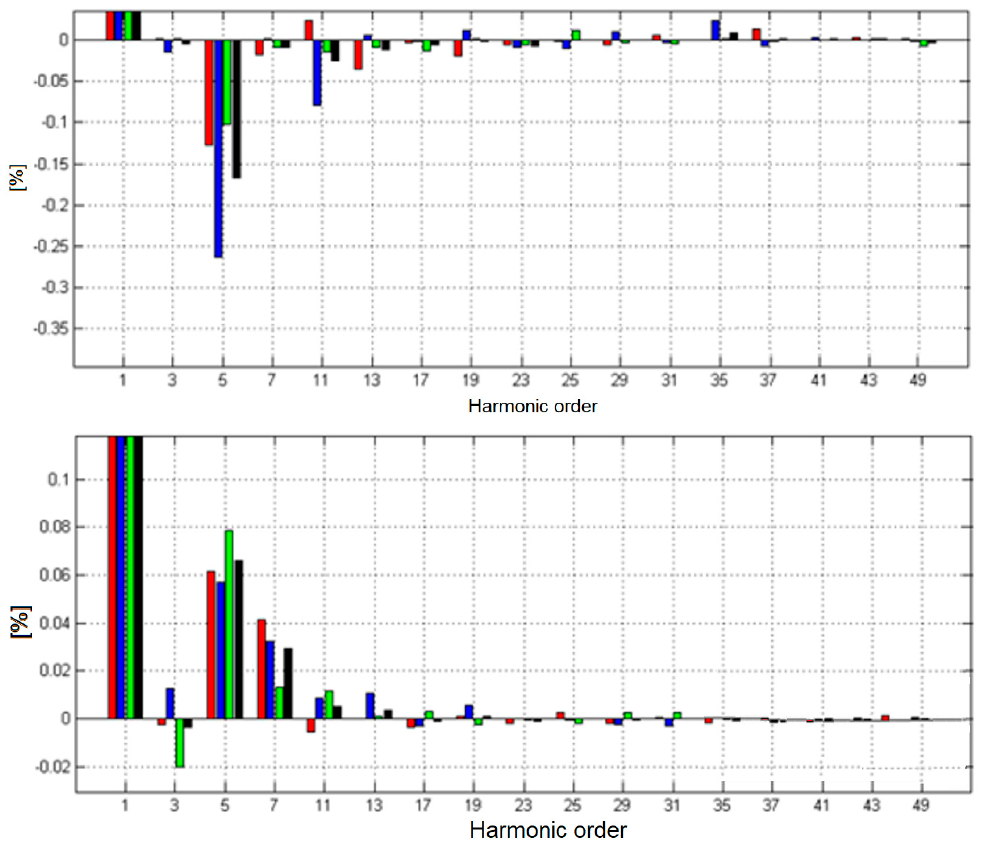
Figure 22. Harmonic spectra of active powers ( top ) and reactive powers ( bottom )—quantities acquired at the primary winding and secondary winding of the transformer for excitation supply.